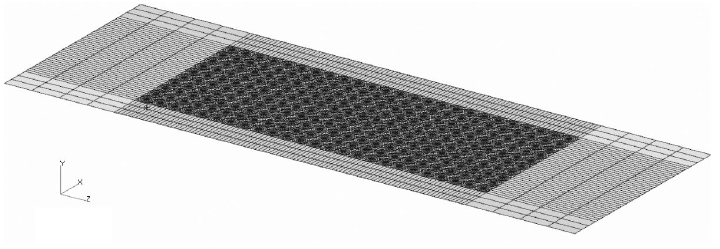
Fig. 39. Elasto-Inertial Dynamic Layer attached to a